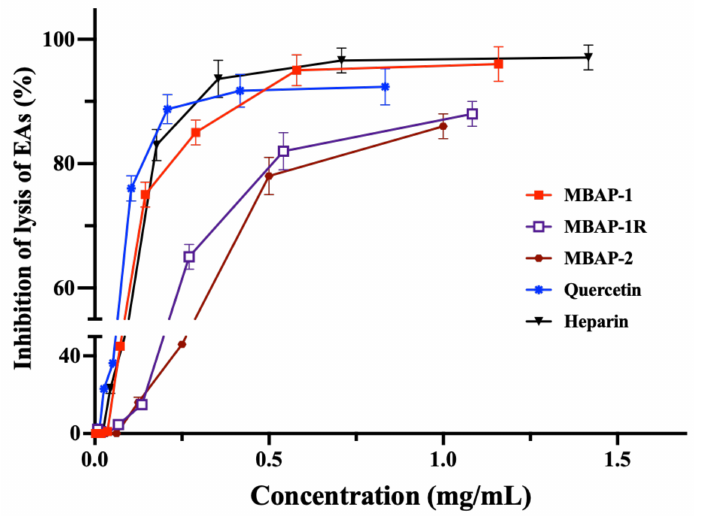
Figure 7. Anticomplement activities of MBAP-1, MBAP-2, MBAP-1R and quercetin.